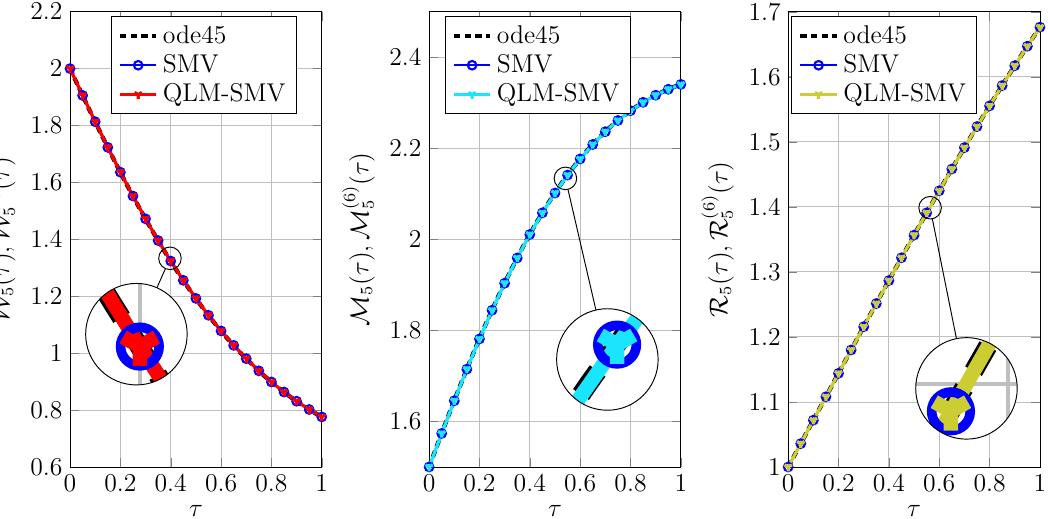
Figure 2. Comparisons of numerical solutions obtained via SMV/QLM-SMV in Test Case 1 with Q =